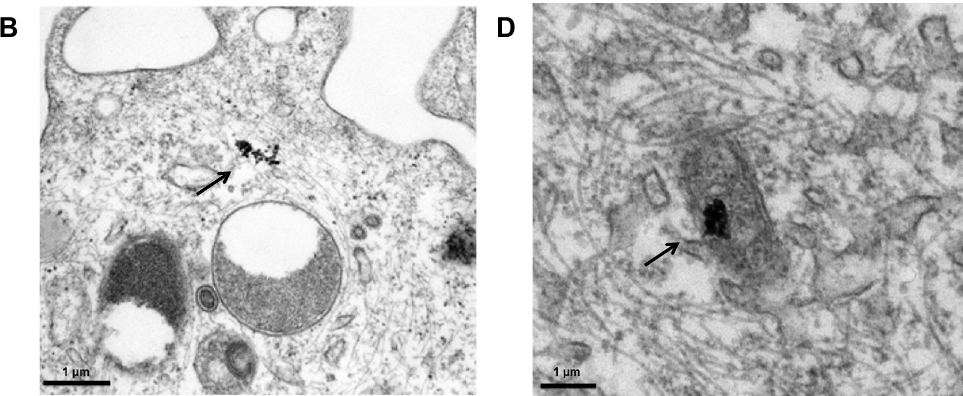
Figure 7. TEM photograph of human mesenchymal stem cells after exposure to ZnO ‐ NP. NP are marked with an arrow. ( A ) After 1 h of exposure, single nanoparticle uptake of dispersed particles and small aggregates was observed. ( B ) After 3 h exposure to ZnO ‐ NP, larger aggregates accumulate, and ( C ) after 1 week, an additional penetration of solitary NP into the cell nucleus was observed. ( D ) Over the observation period up to 3 weeks, an intracellular accumulation in bigger conglomerates and a penetration into other cell organelles (like the mitochondria) by solitary NP or smaller conglomerates was documented. Images were taken at 3000× magnification. Scale bar representing 1 μ m.